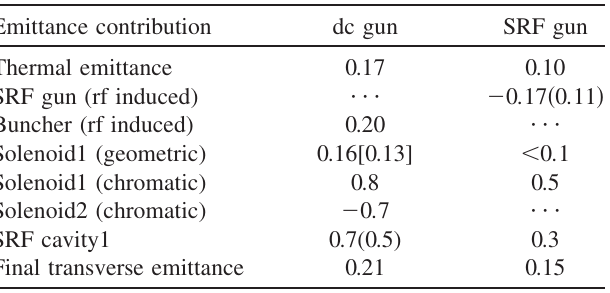
TABLE II. Correlated and uncorrelated emittance contribu- tions (rms normalized in (cid:1) m